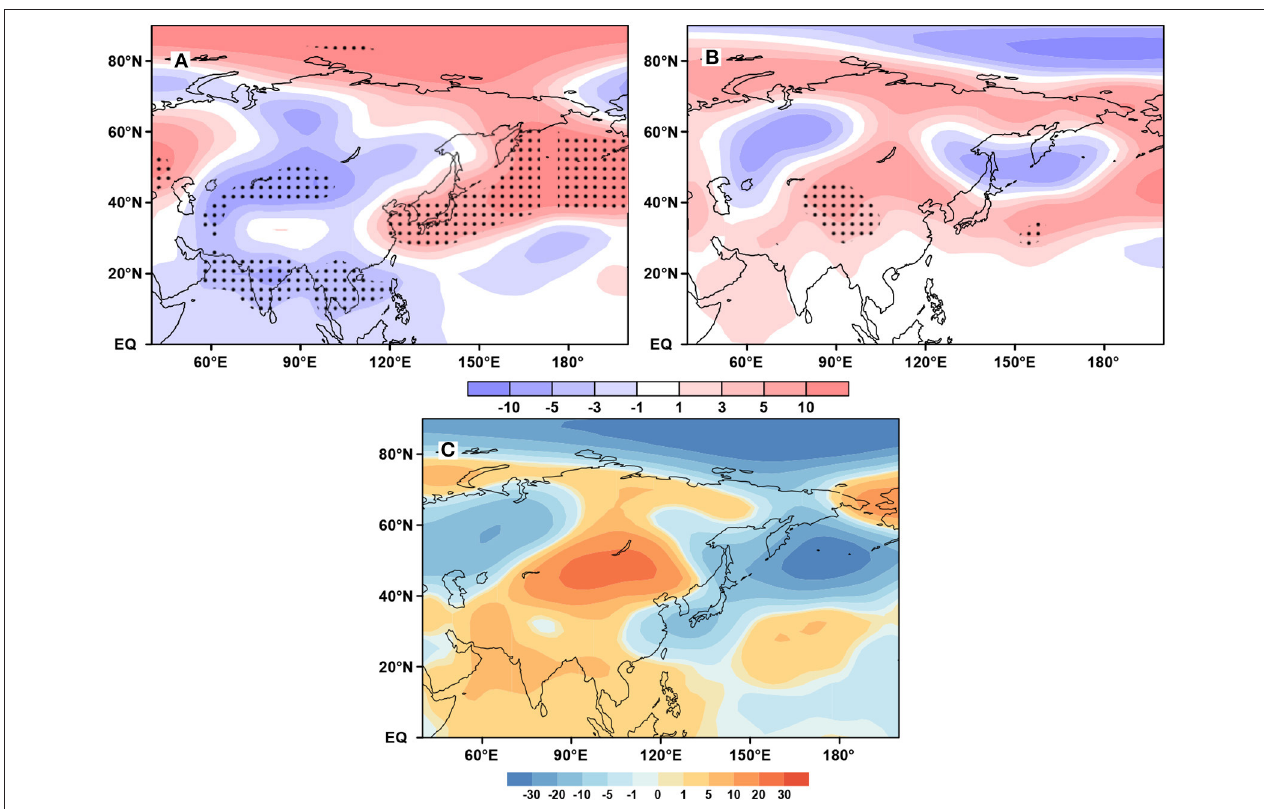
FIGURE 9 | Detrended regression of 500-hPa geopotential height against the KCS index in early summer during (A) the cold period and (B) the warm period (dotted areas indicate the 95% significance level), and (C) difference of 500-hPa geopotential height (unit: gpm) between warm and cold periods calculated by detrended linear